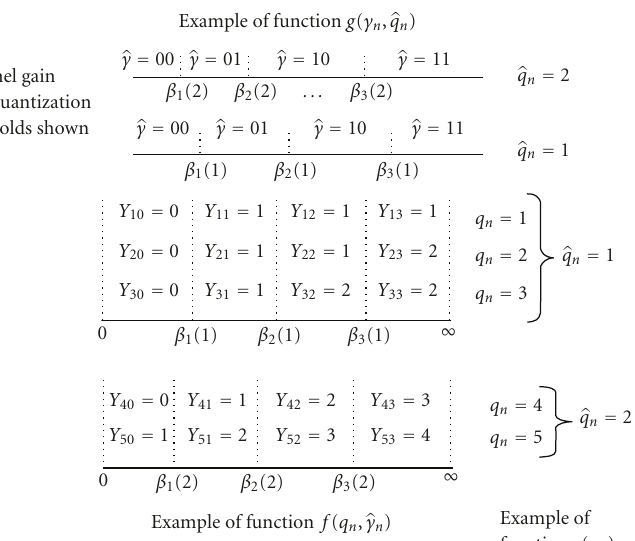
Figure 3: Examples of functions e ( q n ), g ( γ n , (cid:12) q n ), and f ( q n , (cid:12) γ n ) used when N f = 1bit of instantaneous TBIR is available. Number of feedback bits is N b = 2 and bu ff er length is L = 5.